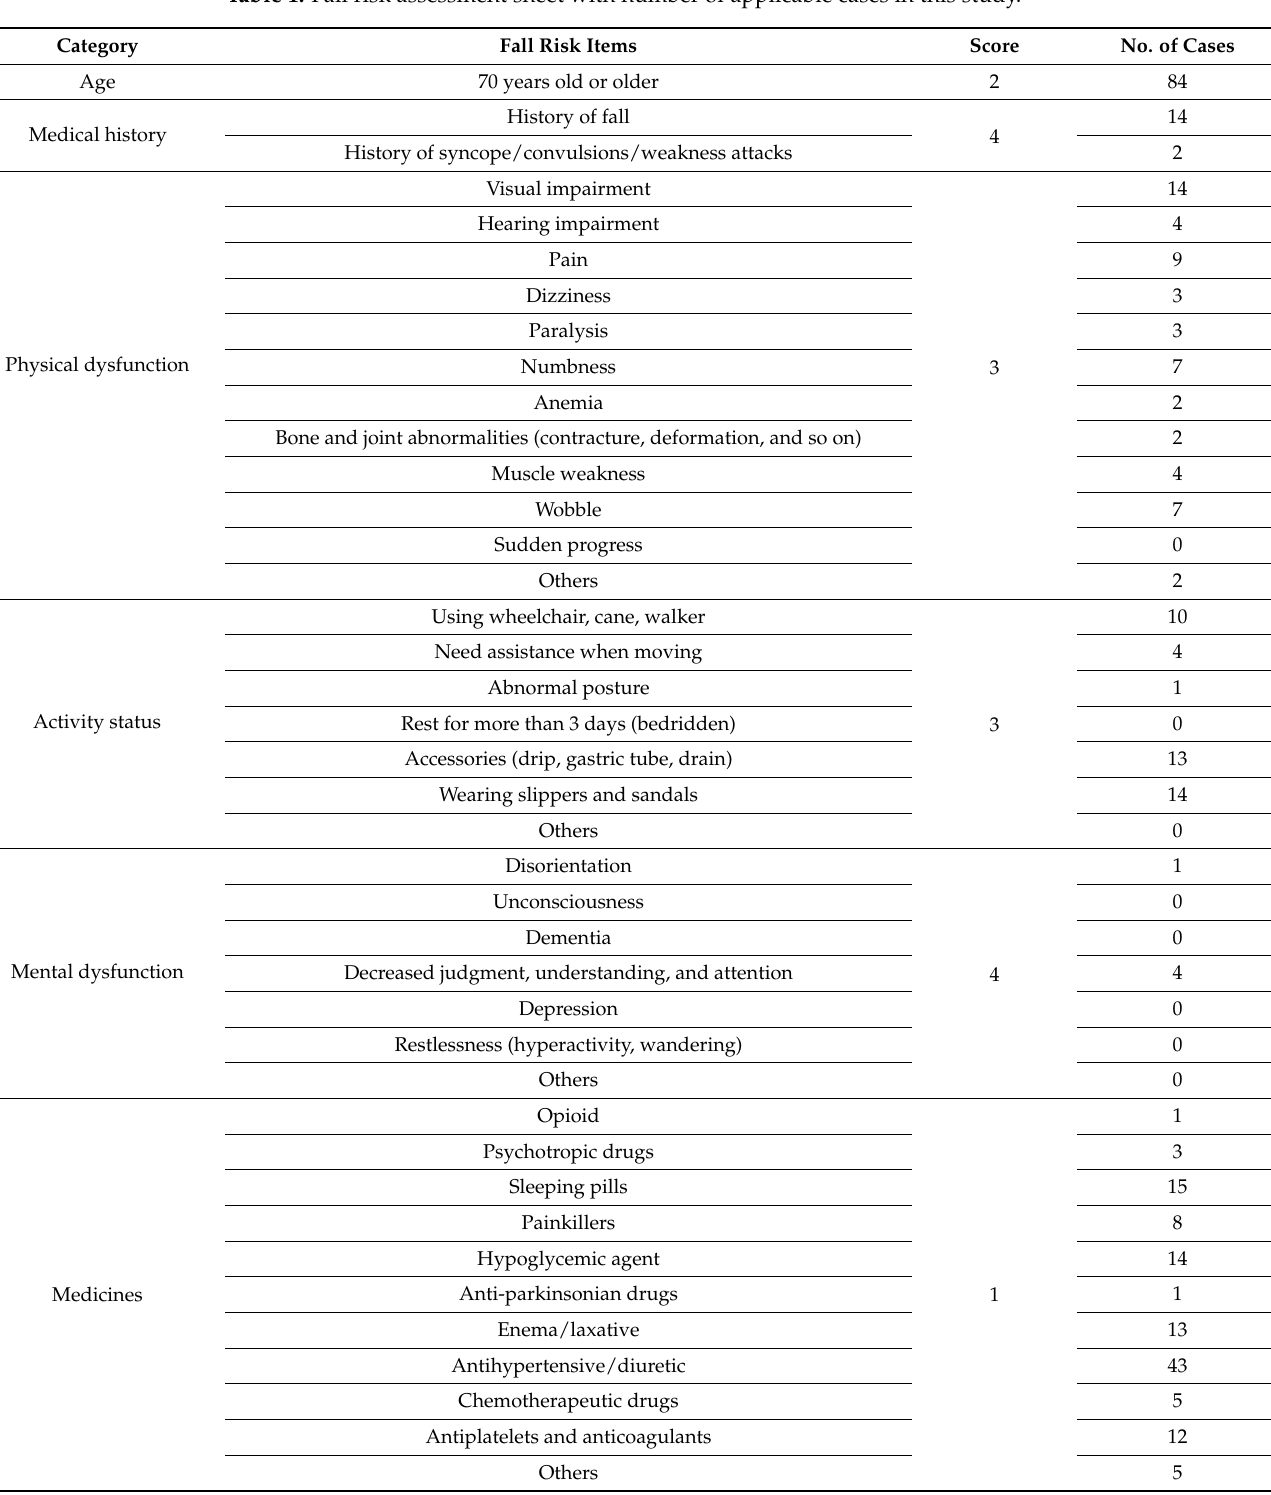
Table 1. Fall risk assessment sheet with number of applicable cases in this